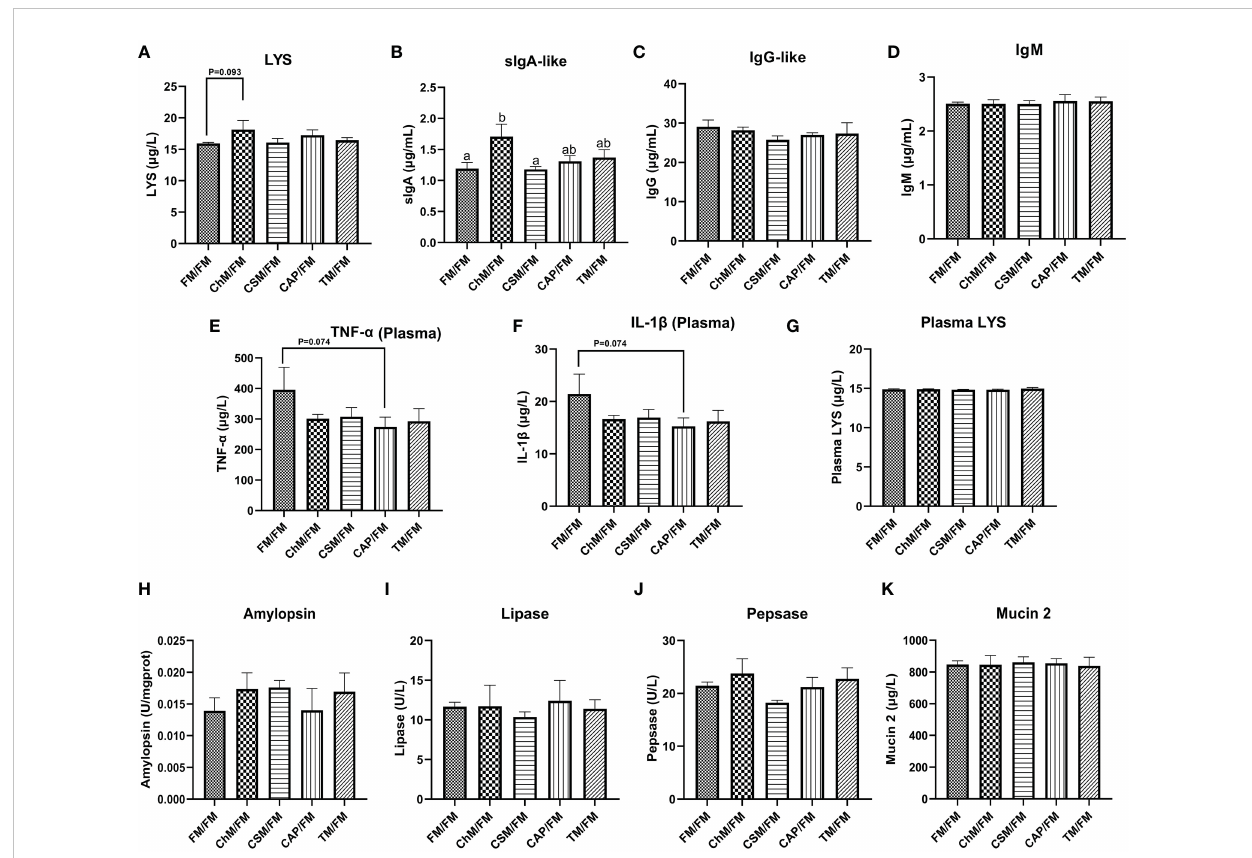
FIGURE 4 The immunological and chemical barriers of juvenile largemouth bass under an alternate feeding strategy were shown as follows: LYS (A) , sIgA-like (B) , IgG-like (C) , IgM (D) , plasma TNF- a (E) , plasma IL-1 b (F) , LYS (G) , amylopsin (H) , lipase (I) , pepsase (J) , and mucin 2 (K) . Data are expressed as mean (S.E.M). Values on each column with different superscripts typi fi ed statistical differences ( P<0.05